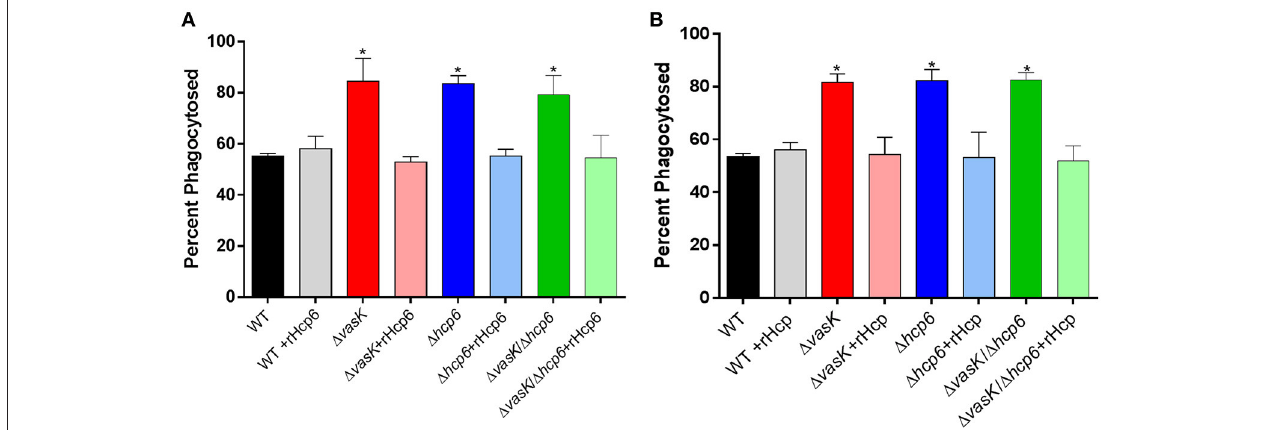
FIGURE 7 | Phagocytosis of WT CO92, 1 vasK , 1 hcp6 , and 1 vasK 1 hcp6 mutants in RAW264.7 murine macrophages with presence of exogenous recombinant Hcps. Macrophages were infected with WT and the indicated mutant strains at MOI of 10 and incubated for 1h with or without 10 µ g/ml rHcp6 [ Y. pestis (A) ] or rHcp [ A. dhakensis (B) ]. Cells were then washed and incubated for 1h with gentamicin to eliminate extracellular bacteria before being lysed for intracellular bacterial enumeration (see legend for Figure 6 ). Two independent experiments with two replicates (for a total n = 4) were performed. The data were analyzed by comparison